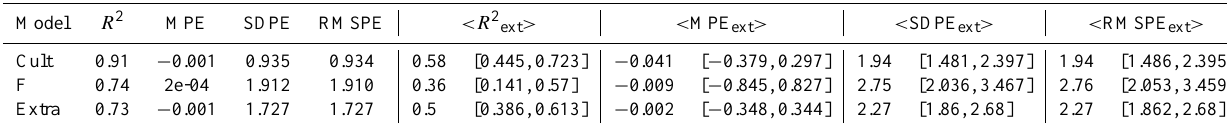
Table 2. Fit and cross validation results for a ratio of 0.9/0.1 training vs. validation datasets. Quality of the fit on the full data set is expressed using R 2 , mean prediction error (MPE, kgm − 2 ), standard deviation of the prediction error (SDPE, kgm − 2 ), and root mean square prediction error (RMSPE, kgm − 2 ). The cross-validation results are expressed using <R 2 ext > , < MPE ext > (kgm − 2 ), < SDPE ext > (kgm − 2 ) and < RMSPE ext > (kgm − 2 ) estimated using the validation datasets. The 95% confidence intervals obtained for the corresponding normal distributions using the standard percentile method are given in brackets.